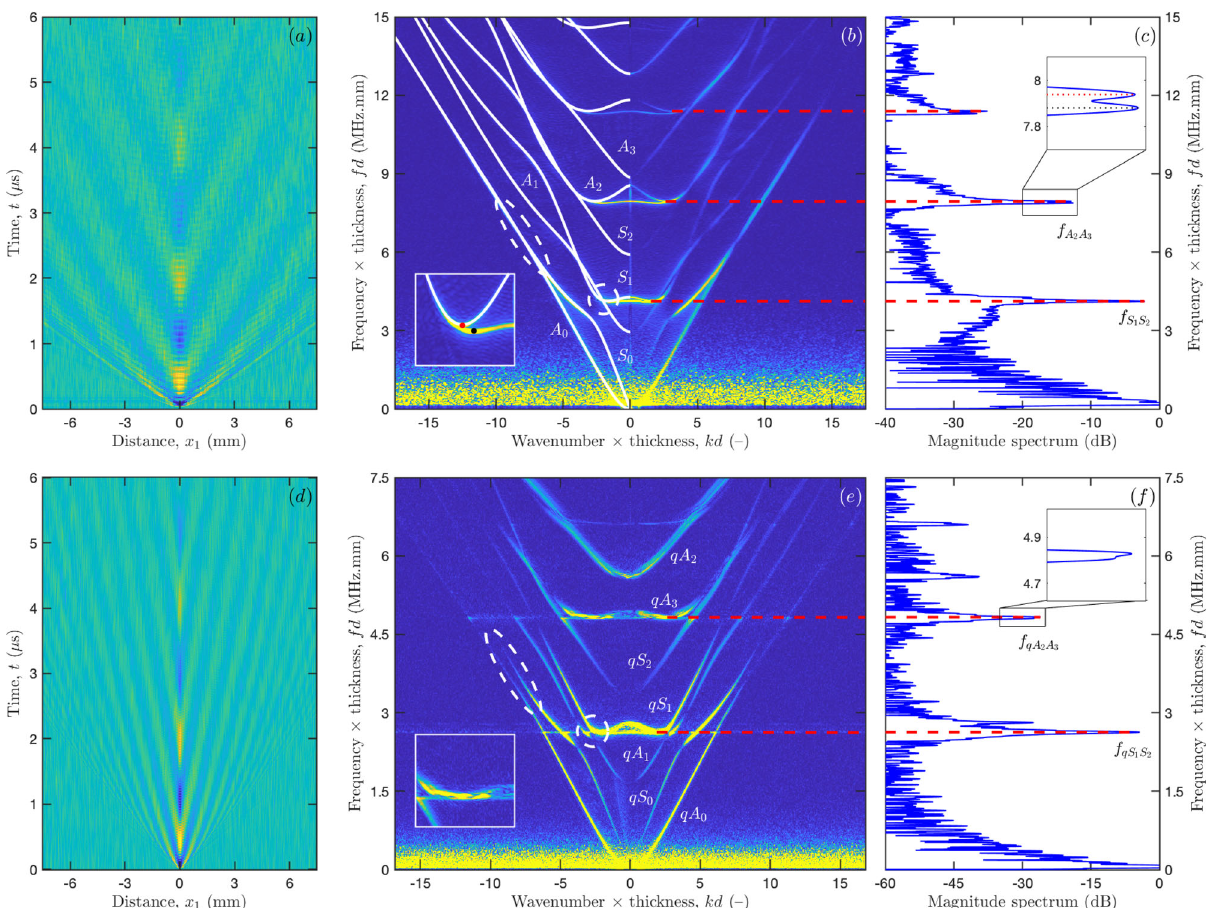
Fig. 3 Laser ultrasonics measurements for bulk silicon (upper panels) and nanoporous silicon (lower panels). a – d Spatio-temporal broadband displacements measured on the samples with the laser ultrasonics setup; b – e Dispersion curves in the normalised wavenumber-frequency plane, obtained by 2D Fourier transform of the spatio-temporal signals (for bulk silicon, theoretical guided modes are displayed in white continuous lines for comparison); and ( c – f ) zero group velocity (ZGV) resonances (the insert depicts the presence of two ZGV resonances for bulk silicon, where the red one is the actual resonance belonging to [110]-axis and the black one reveals the concurrent excitation of the resonance belonging to [100]-axis due to in-plane